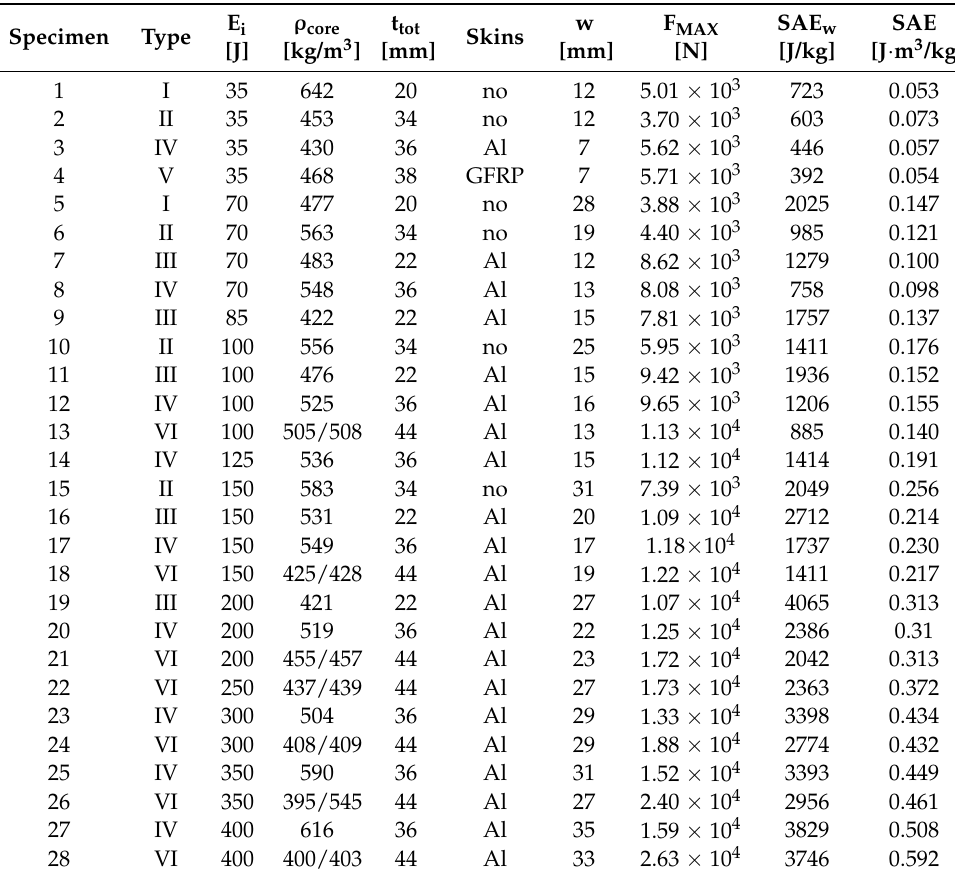
Table 1. Results of the impact tests.